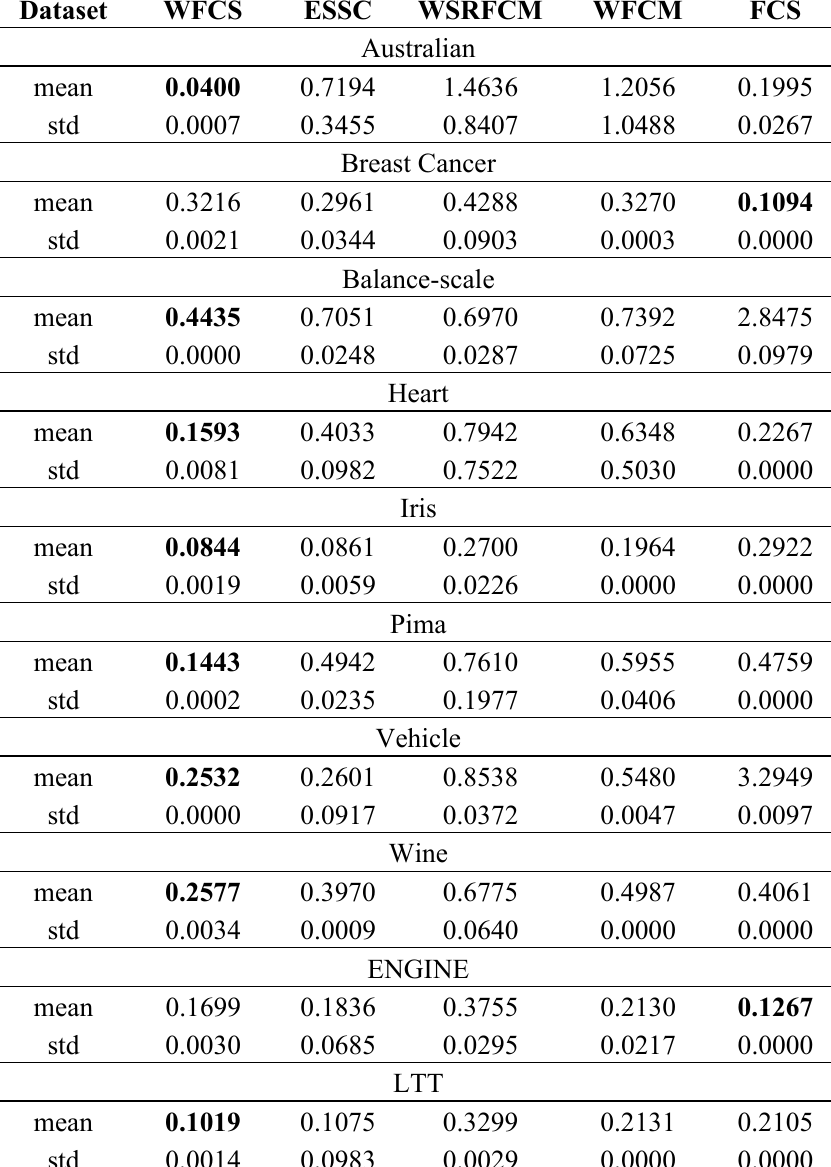
Table 5. Xie-Beni (XB) index of